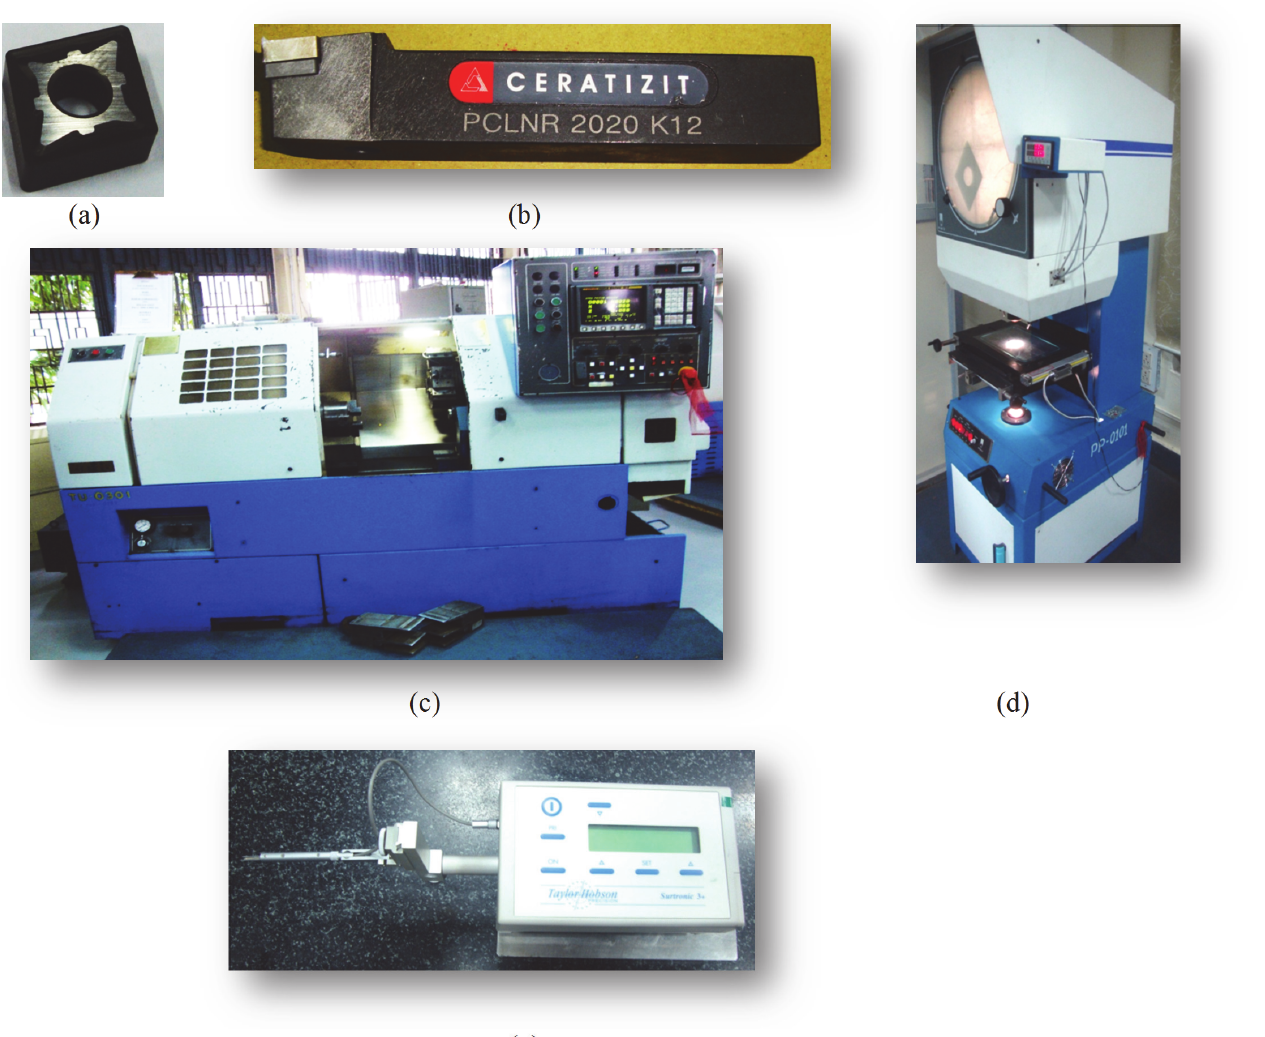
Fig. 4. The components of machining setup (a) carbide insert (CNMG 120408-M5), (b) tool holder (PCLNR2020K12), (c) CNC Lathe (Model LT-16 CNC), (d) Tool Profile Projectors (PP 400 TE) and (e) surface roughness tester (Taylor Hobson, Surtronic